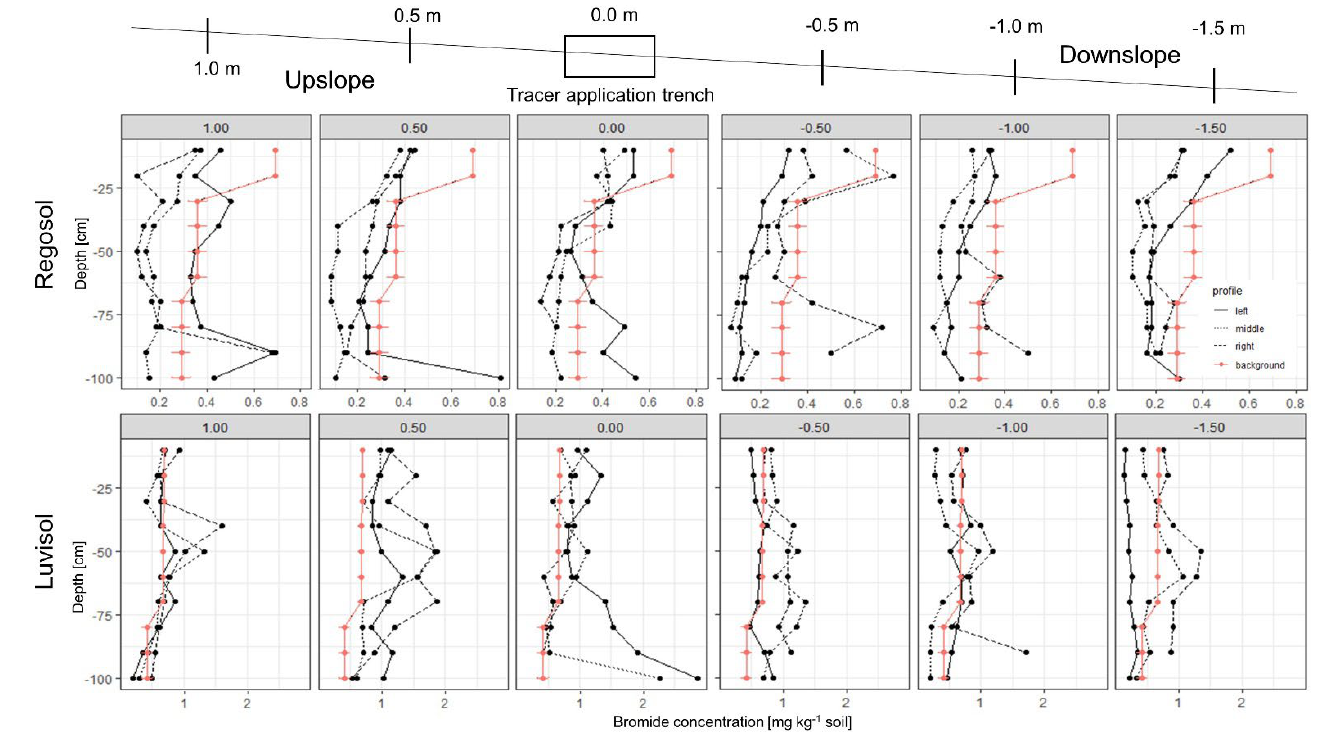
Figure 6. Bromide concentrations (mg Br - kg −1 soil) 1.0 m, 0.5 m above, in and 0.5, 1.0, and 1.5 m below the tracer application trench for the Regosol and Luvisol site. Red lines are background concentrations: note that these were determined on a single profile on the respective soils with two to three replicates in each horizon. Note the different scales for concentration in Luvisol and Regosol.